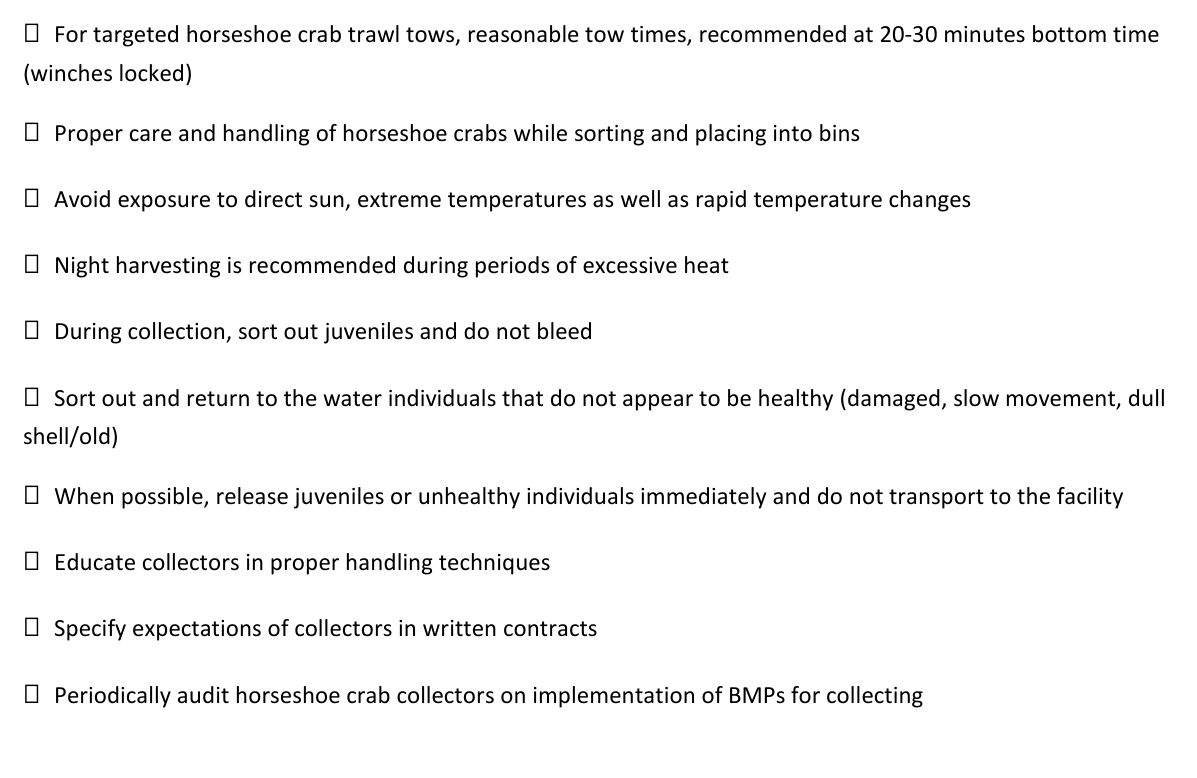
Table 3. Best Management Practices (BMPs) for Biomedical Horseshoe Crabs.